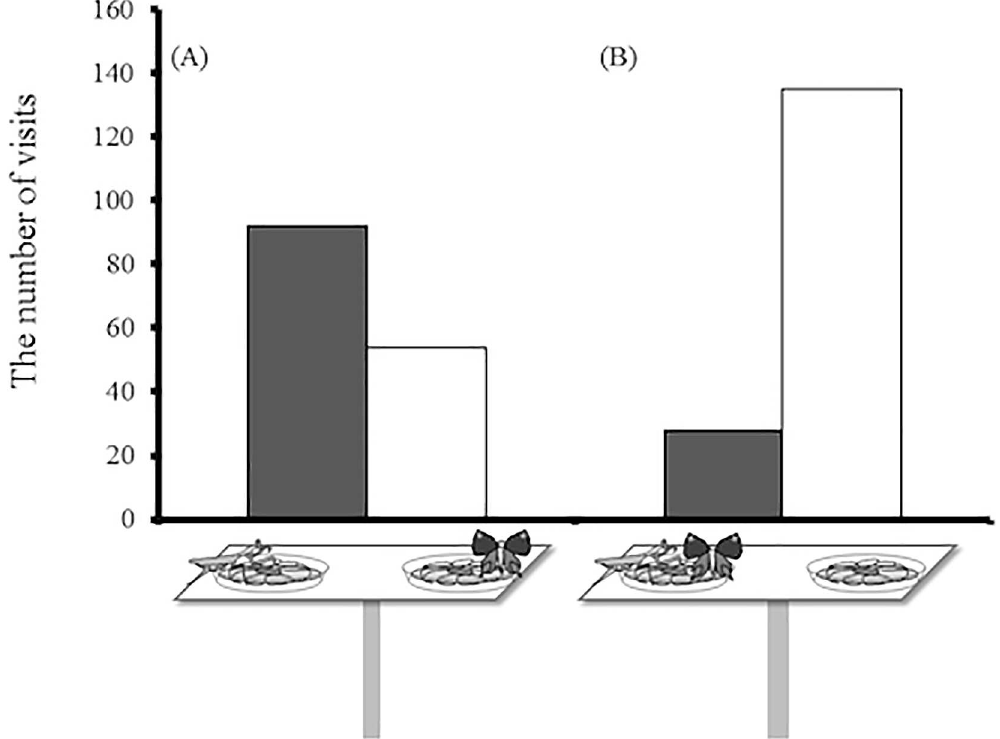
specimenof T . aridifolia